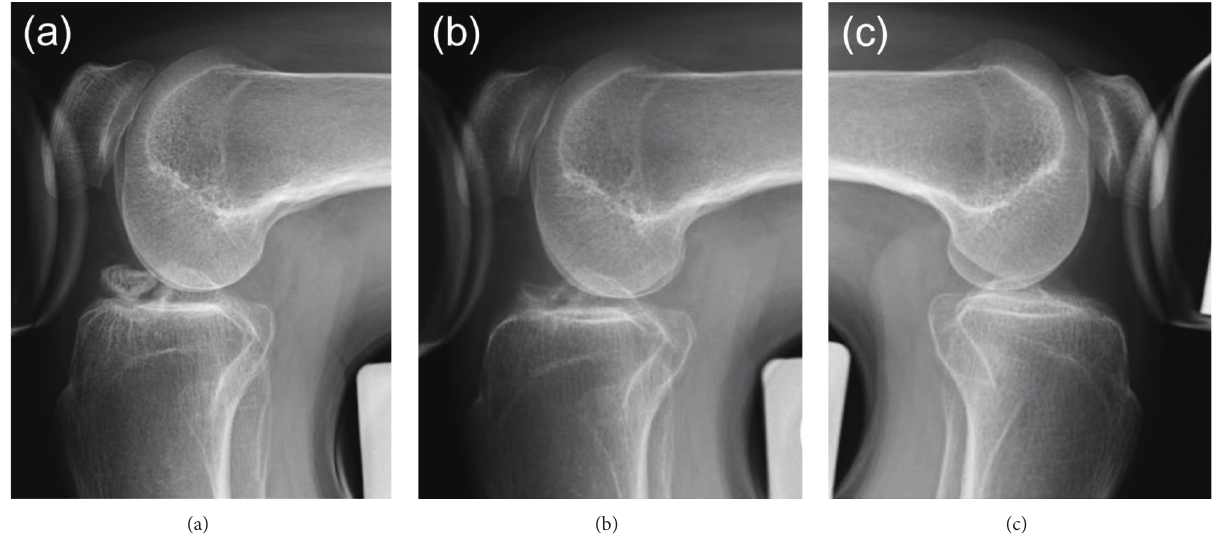
Figure 3: Stress radiographs with anterior drawer tests showing no difference between the (a, b) right and (c) left knees at (a, c) initial examination at our hospital and (b) 2 years after surgery.